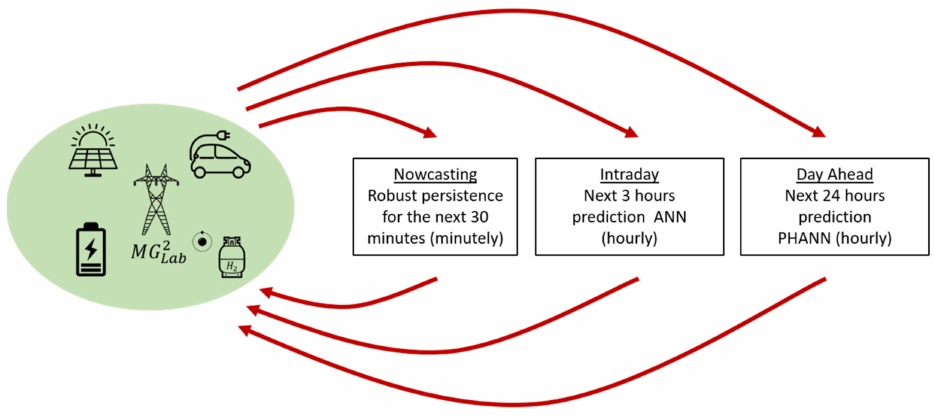
Figure 1. Forecasting scheme and timing for photovoltaic (PV) forecasting